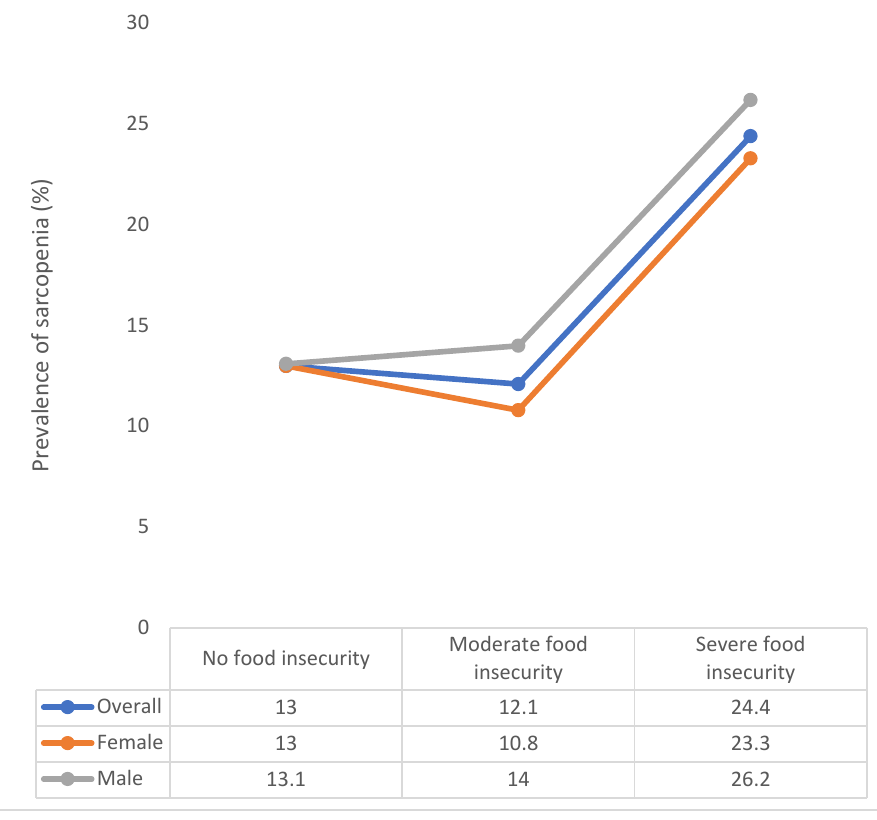
Figure 1. Prevalence of sarcopenia by food insecurity status (overall and by sex).